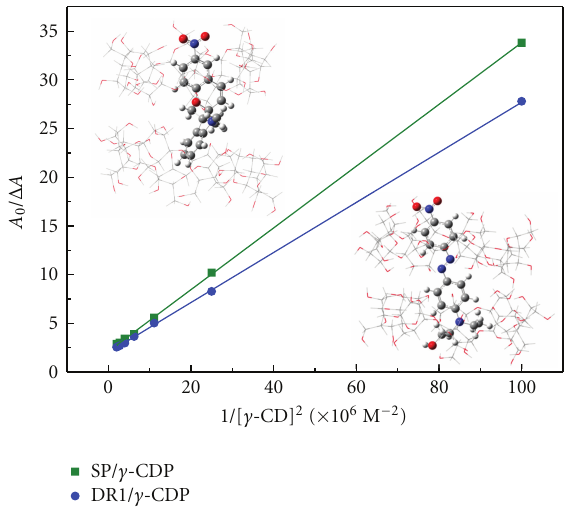
F 2: e linearity of the data when 1:2 complexation of DR1: -CD and SP: -CD is assumed. e insets show the opti- mized complexes. 𝛾𝛾 𝛾𝛾